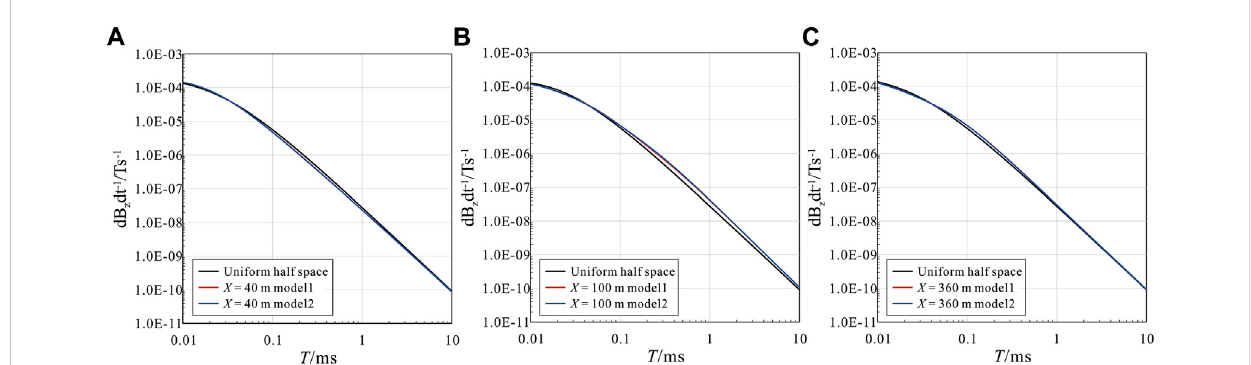
FIGURE 6 Single-point decay curves of synthetic multilayer models and corresponding uniform half space. (A) : X = 40 m. (B) : X = 100 m. (C) : X = 360 m.